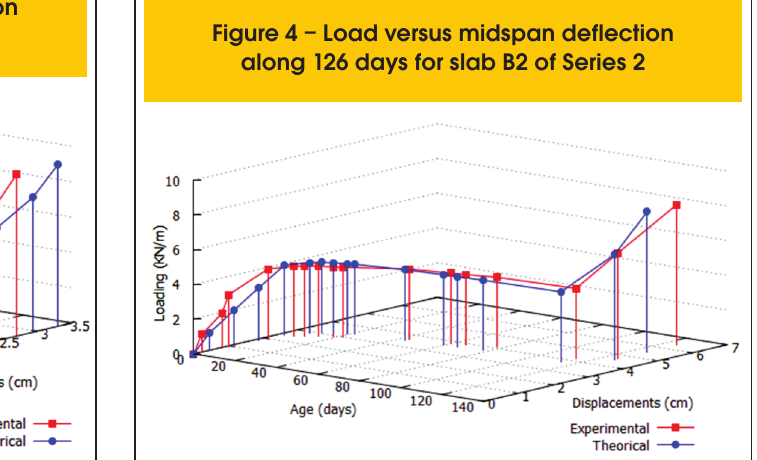
Figure 3 – Load versus midspan deflection along 119 days for slab A1 of Series 1 Figure 4 – Load versus midspan deflection